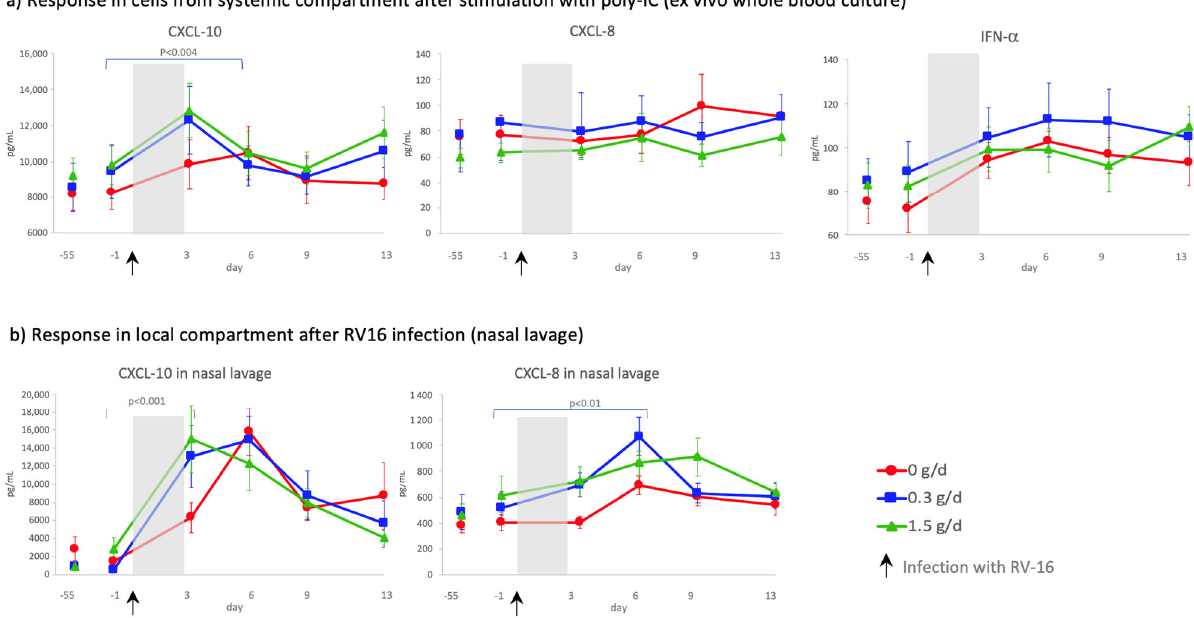
Figure 5. ( a ) Concentration of CXCL-10, CXCL-8 and IFN-α in the supernatant of whole blood cultures stimulated with the viral antigen poly-IC (nested subset). Each symbol represents mean ± SEM of minimal 12 subjects per group. ( b ) Concentration of CXCL-10 and CXCL-8 in nasal lavage at baseline (d-55), just before (d-1) and during rhinovirus infection (d3–13). Symbols represent means ± SEM of ITT population ( n = 146). p values indicate the time interval after infection during which the groups are significantly different. Shaded area indicates time between infection and first biological marker sampling point.